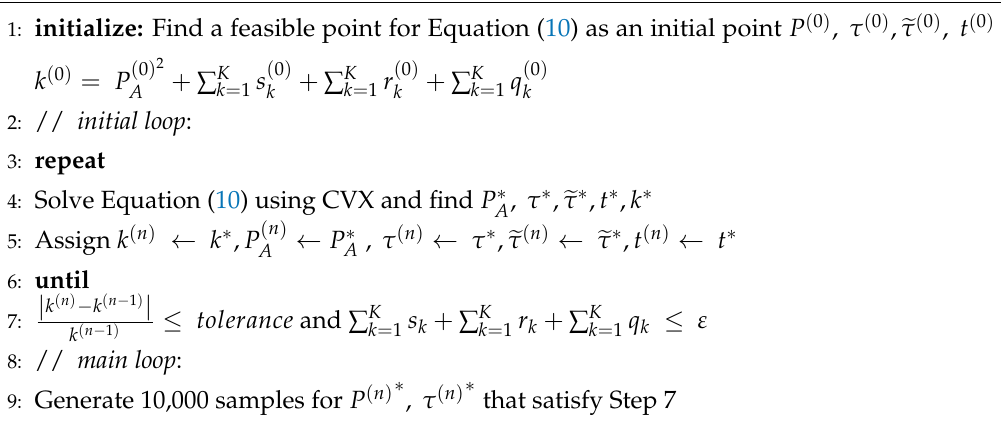
Algorithm 2 SPCA-based iterative algorithm to generate data for multiple